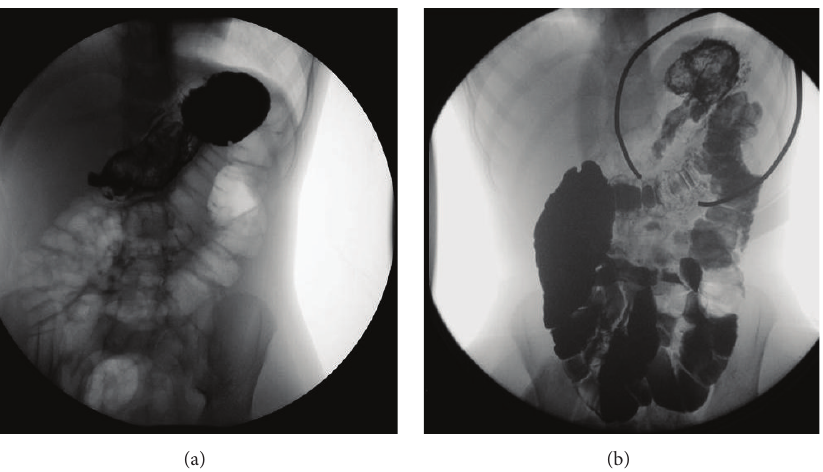
Figure 1: 2012 upper GI study showing gastric bezoar (a); 2014 upper GI study showing gastric bezoar (b).